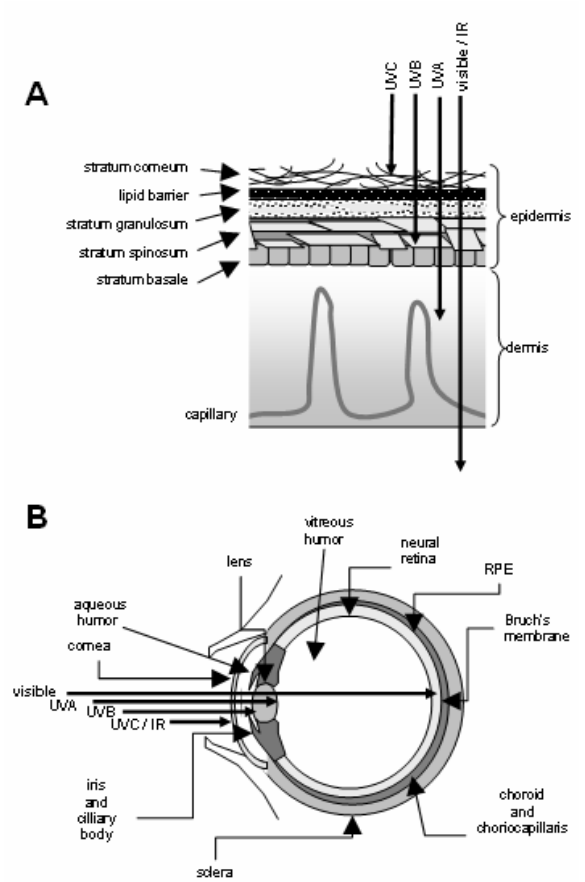
Figure 9: Penetration of skin and eye by solar radiation. (A) Diagram of skin. (B) Diagram of eye.